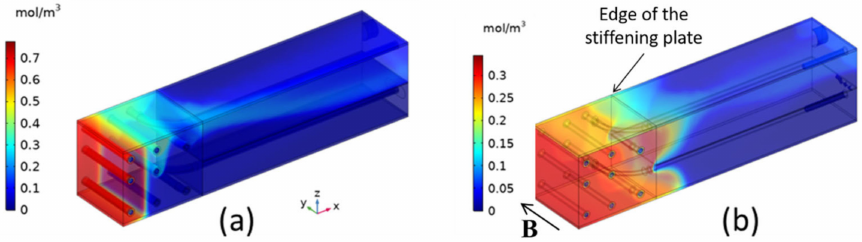
Figure 13. Tritium concentration in LiPb and Eurofer for ( a ) hydrodynamic ( Ha = 0, Gr = 4.78 × 10 10 ) and ( b ) MHD ( Ha = 10830, Gr = 4.78 × 10 10 ) cases.